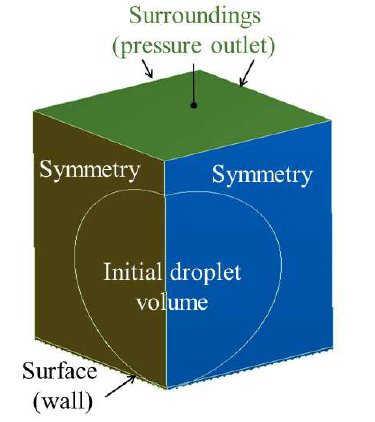
Fig. 4. Microstructure – sketch.